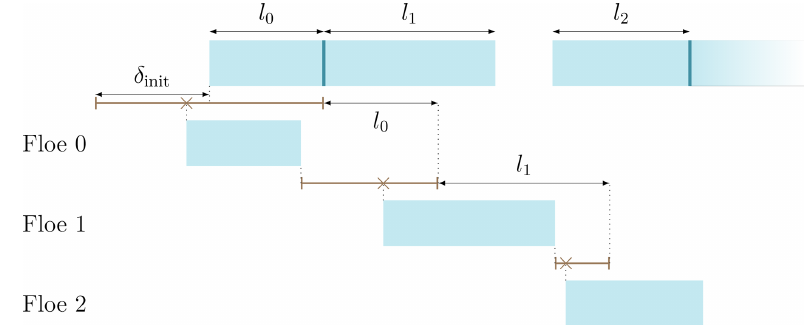
Figure A1. Illustration of the floe repositioning method. The top row shows current floes with identified breakup location marked by vertical bars and the resulting lengths. Successive rows show the iterative positioning as described in the text. Below each row, a segment shows the interval from which a location will be randomly drawn for the next floe; the cross marks that location.